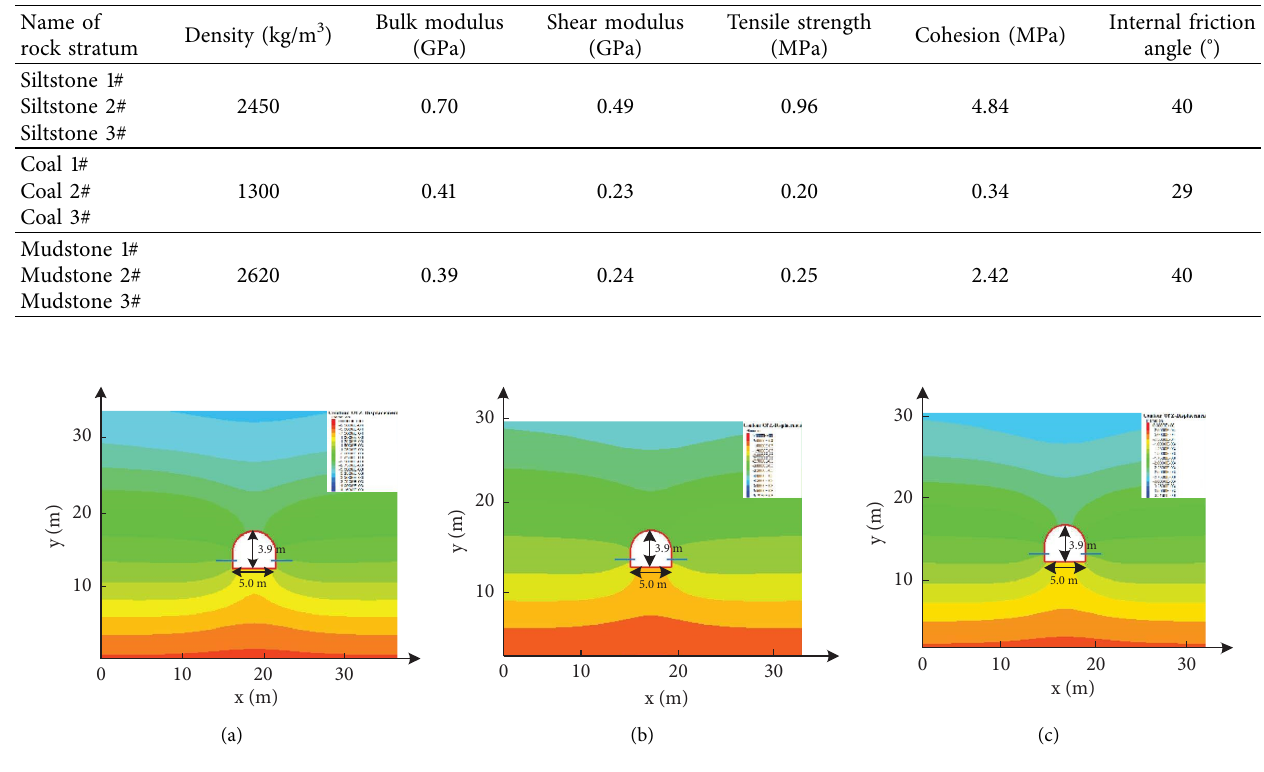
Table 2: Rock layer physical and mechanical parameters table.